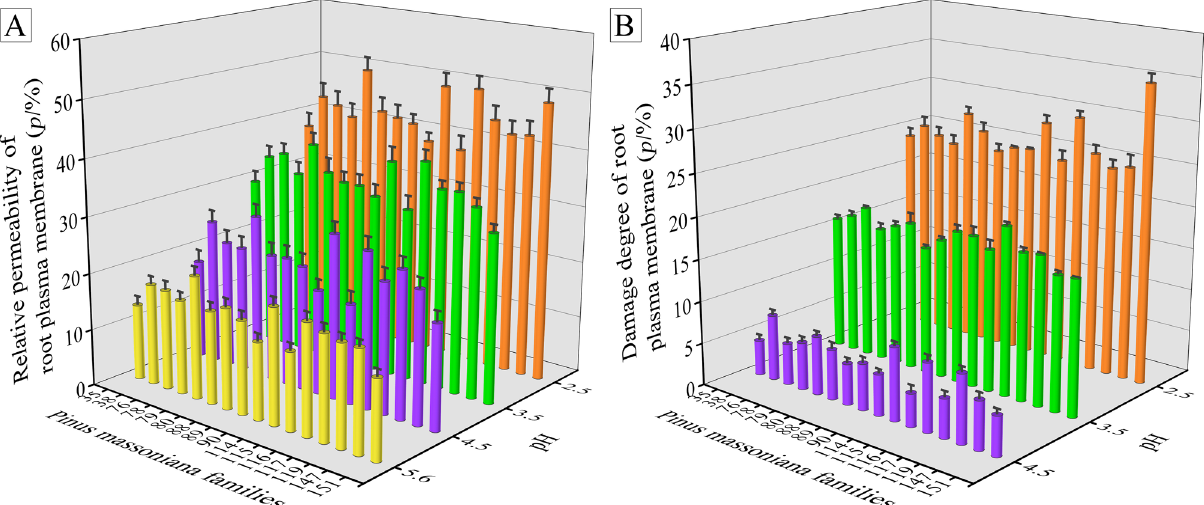
Figure 3. ( A ) The relative permeability ( p /%) and ( B ) damage degree ( p /%) of root plasma membrane of 16 Masson pine families exposed to the SAR. The value of membrane damage degree of Masson pine families at pH 5.6 is 0, which is not shown in ( B ). Results are expressed as mean ± standard error (n = 3).